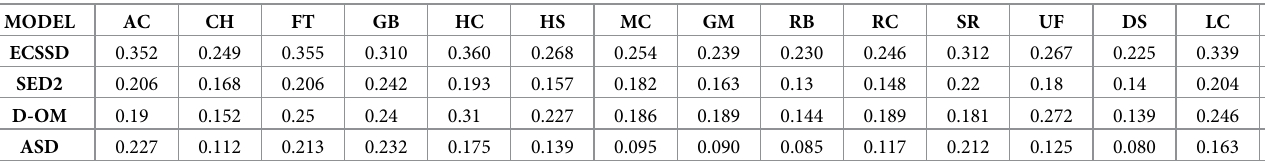
Table 3. Comparison of MAE of the proposed model with current approaches. MODEL